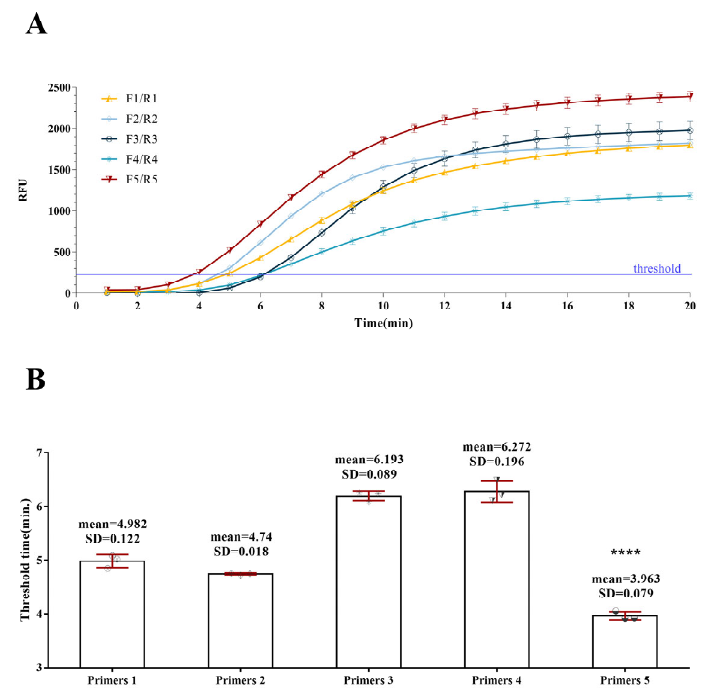
Figure 1. Primer screening. ( A ) Amplification curves of the positive plasmid samples using different primer sets. ( B ) Threshold times of the amplifications using different primer sets. SD: standard deviation. Compared with each group, significant differences were indicated with asterisks: ****, p <